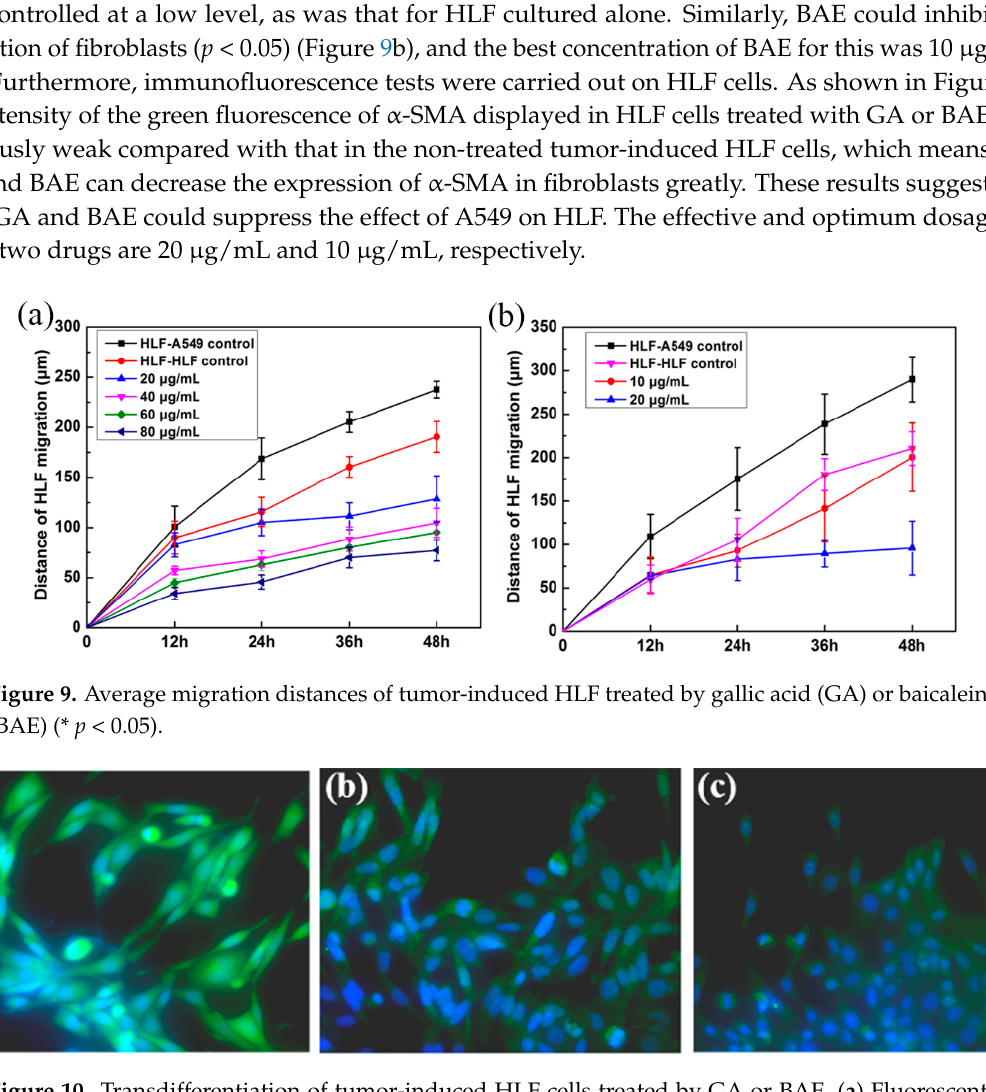
Figure 10. Transdifferentiation of tumor-induced HLF cells treated by GA or BAE. ( a ) Fluorescent images of HLF cells without any drugs. ( b ) Morphology of HLF cells under GA. ( c ) Cellular shapes of HLF treated with BAE.